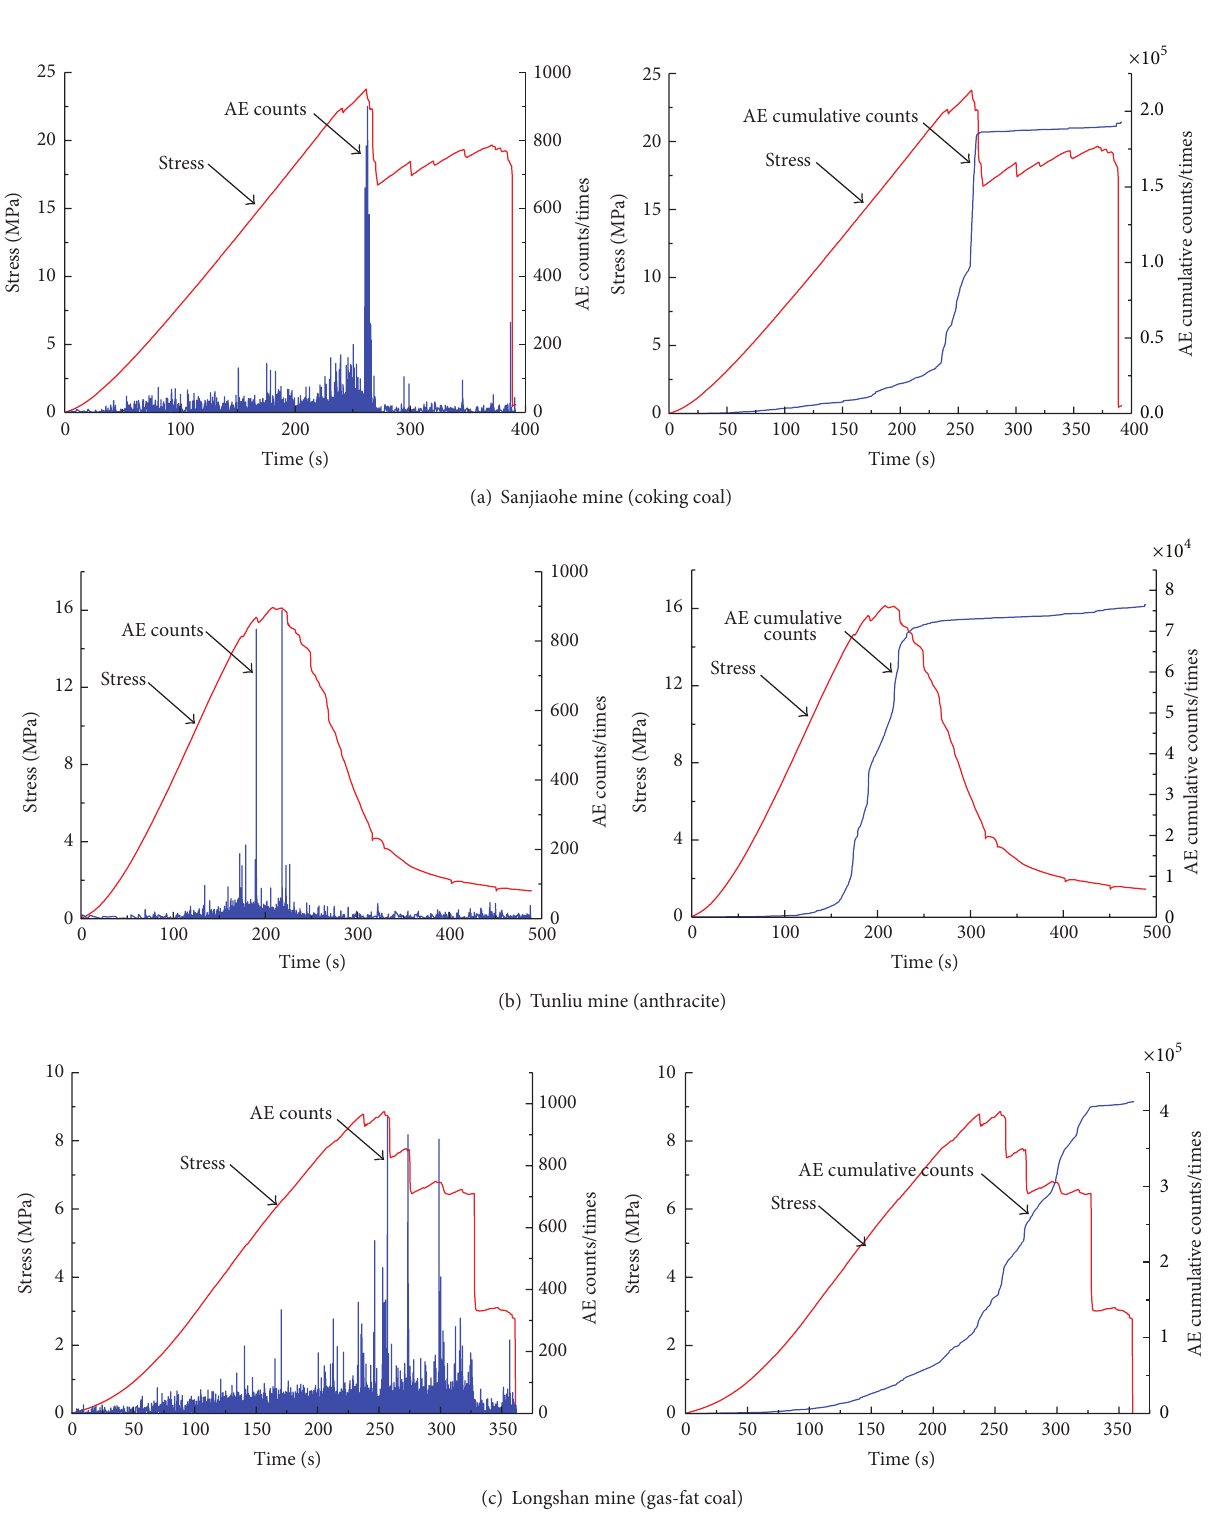
Figure 7: Acoustic emission characteristics with different